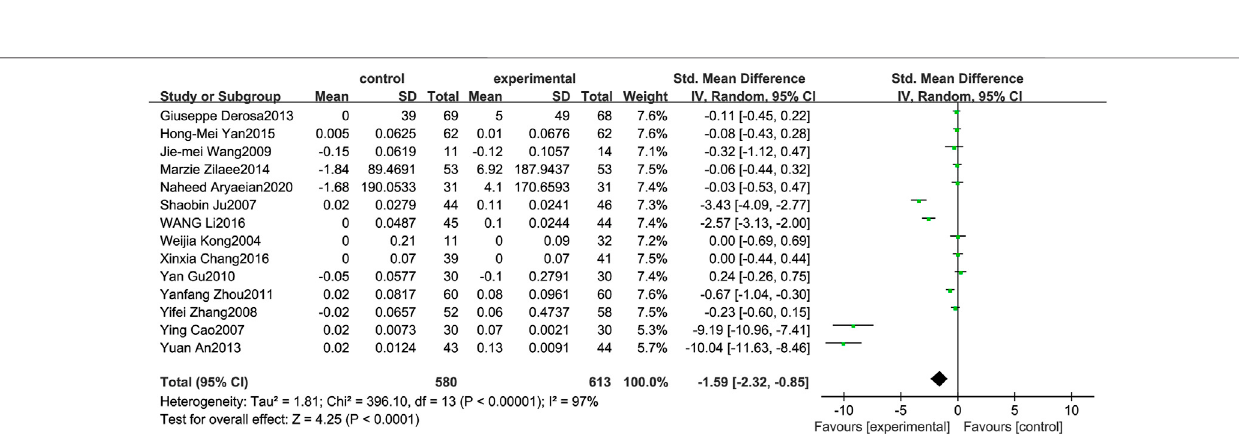
FIGURE 6 | Meta-analysis and migration analysis of the effect of berberine on high-density lipoprotein. Forest plot illustrates the differences in changes in high- density lipoprotein in adults with metabolic disease who did or did not receive berberine in 13 trials ( n (cid:1) 1,133). The mean difference (blue squares), 95% CI (horizontal lines through blue squares), and pooled-effect sizes (green diamonds) were presented using random-effect Hedges models.